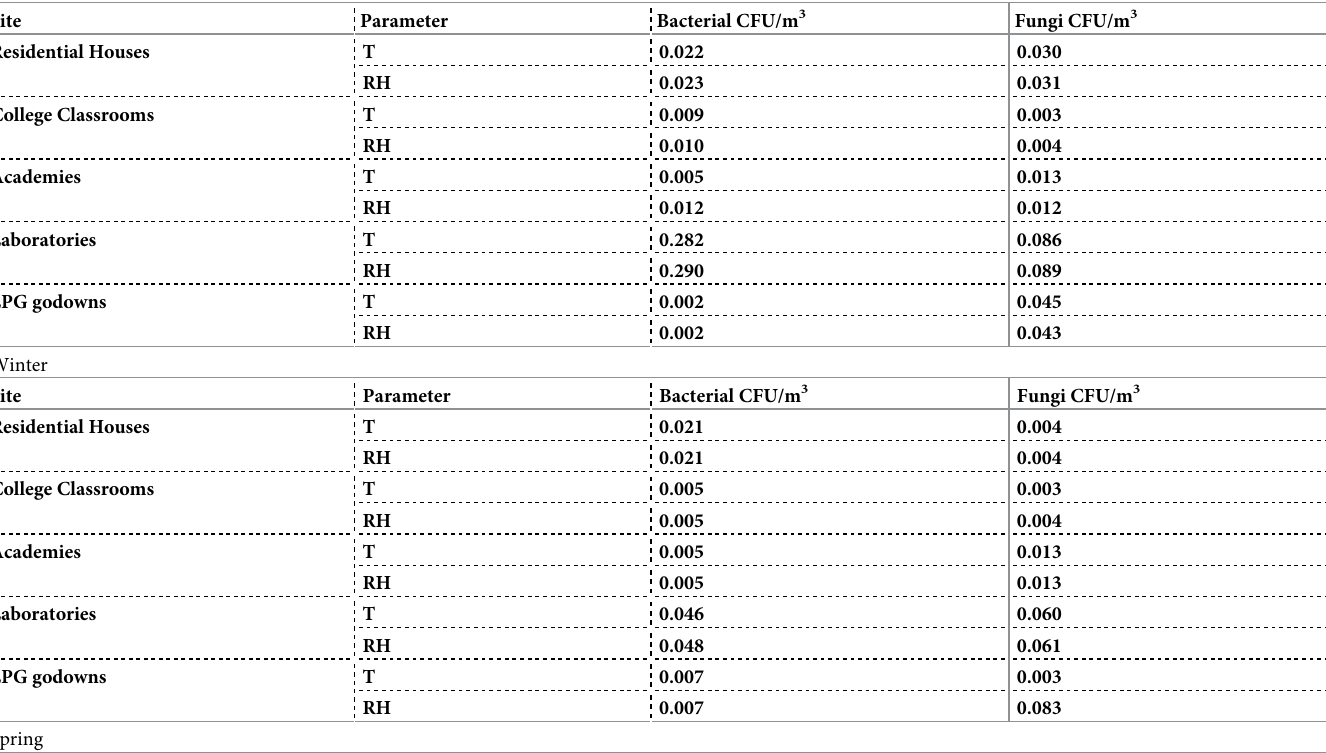
Table 6. Correlation matrix of meteorological parameters temperature and relative humidity with microbial concentrations in winter and spring seasons (P < 0.05 means positive correlation with meteorological parameters; significant values are in boldface.).